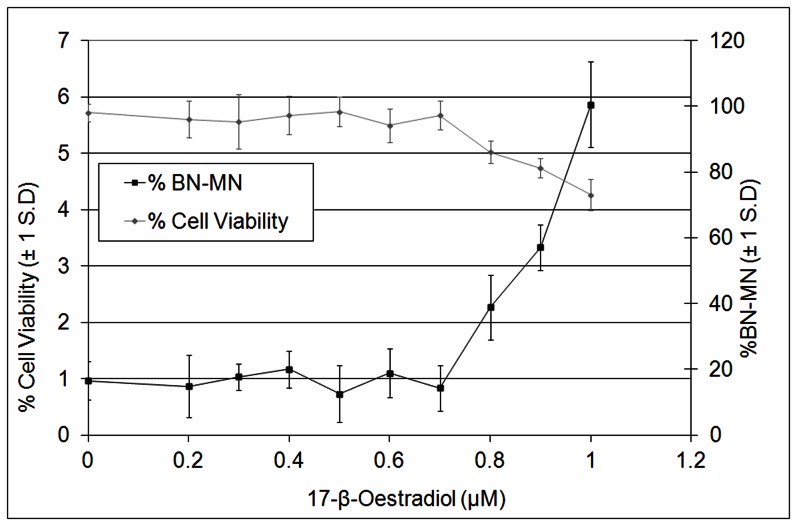
Using the CBMN to assess % binucleate cells with MN (%BN-MN) and cell cytotoxicity and/or cytostasis (% Cell Viability) in AHH-1 cells after E2 treatment at super-physiological concentrations.3×1,000 binucleate cells were examined for the presence of BN-MN. Cell viability (%) was calculated from the cytokinesis-block proliferation index (CBPI) measure (OECD, 2010) by scoring approximately 8,000 cells per dose. 0.8 µM E2 and above were significant to p<0.05 for BN-MN, by comparison to the control using Dunnett’s.